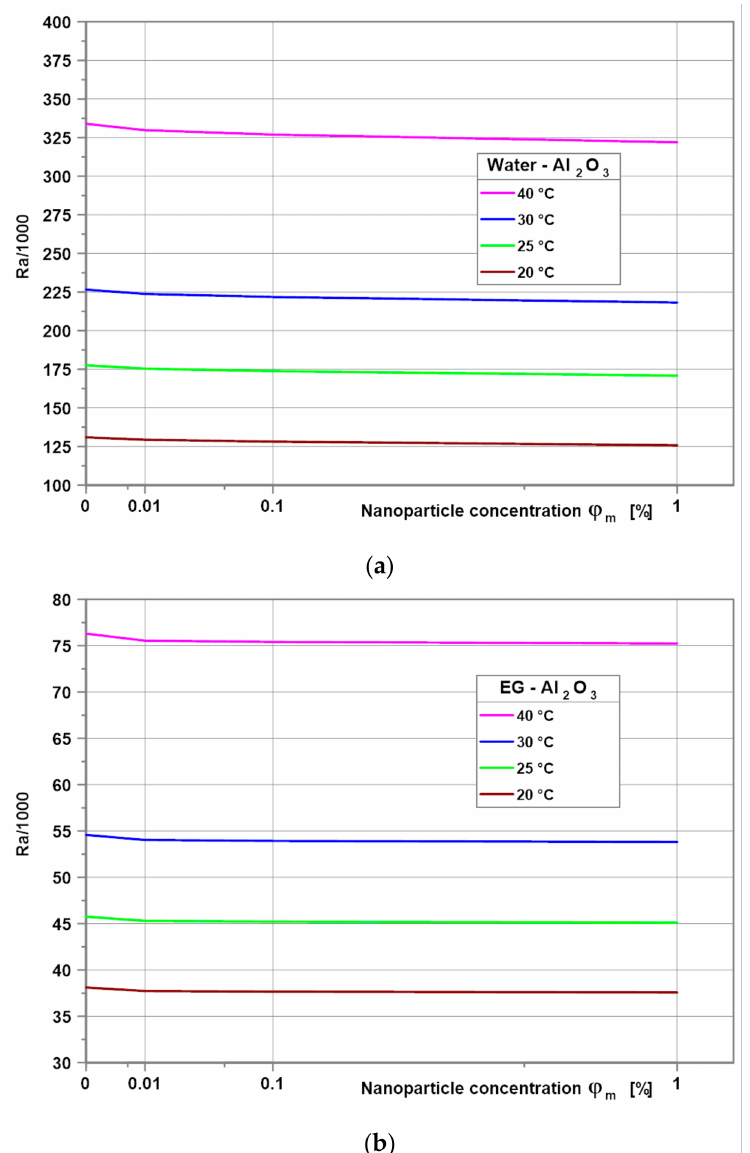
Figure 9. Variation of Ra number with temperature and nanoparticle concentration for water-based ( a ) and EG-based ( b )